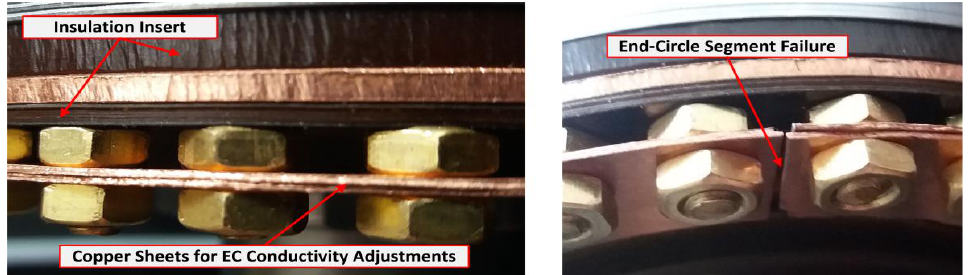
Figure 12. Construction adjustments of the test rotor with overall ring conductivity decrease and disconnecting in the end-ring segment between the bars.